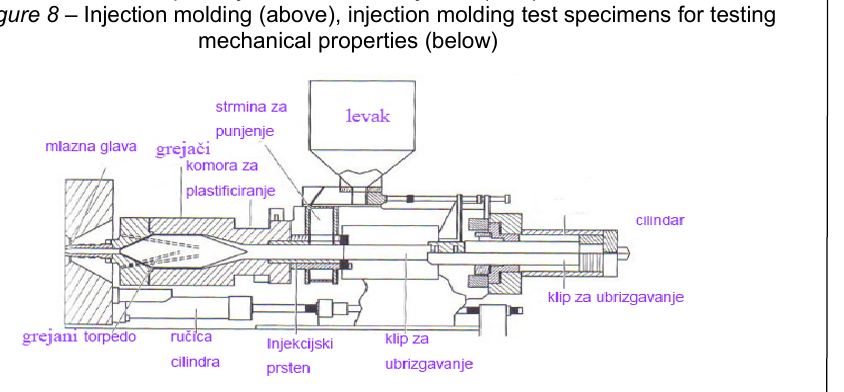
Figure 8 – Injection molding (above), injection molding test specimens for testing mechanical properties (below)